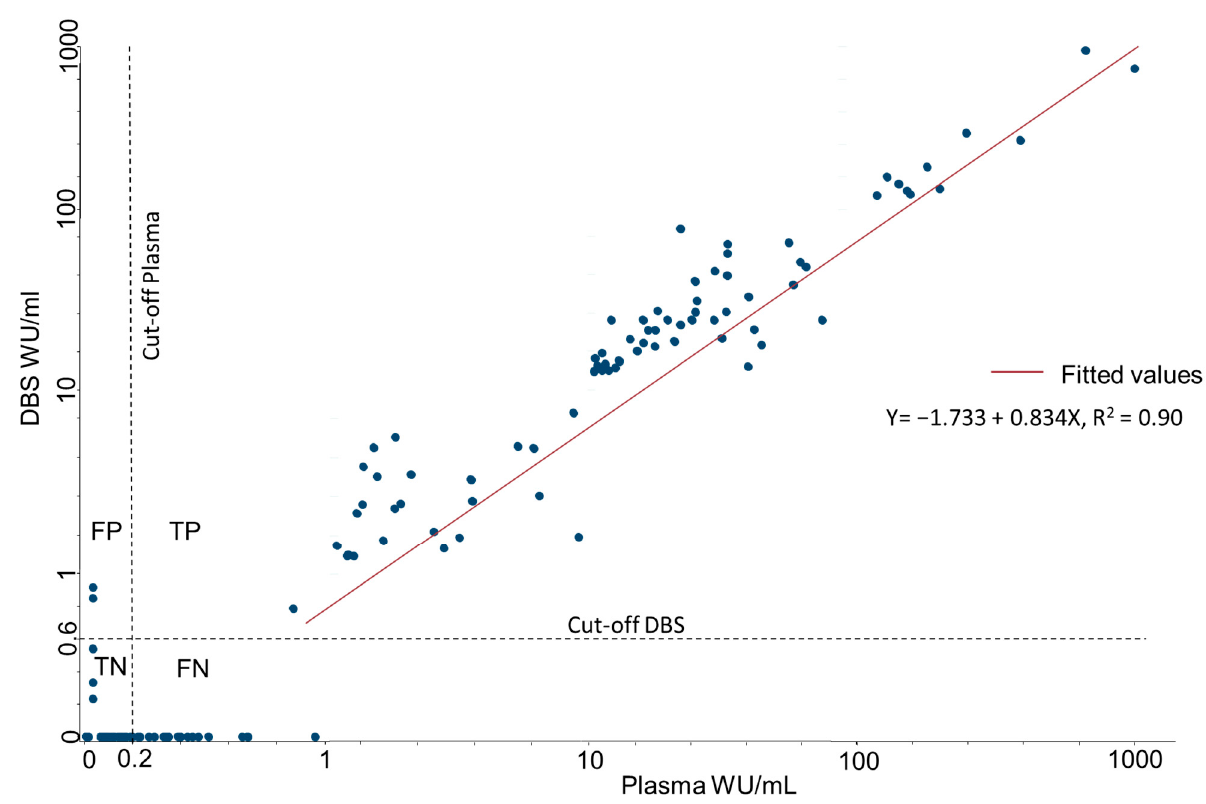
Figure 4. Positive correlation between IgG titer (WU/mL) and the sensitivity from DBS sample (or- ange line). Dotted lines represent the level of IgG of which 90% of people with an infection (blue) or vaccination (green) will be above.